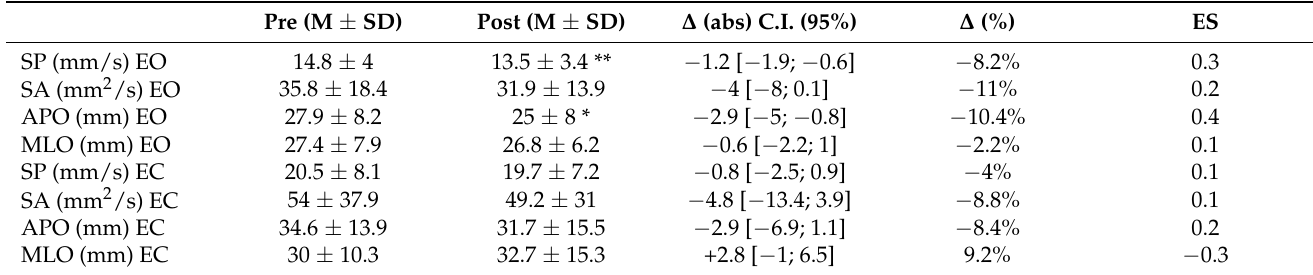
Table 3. Changes in anthropometric and postural control parameters after